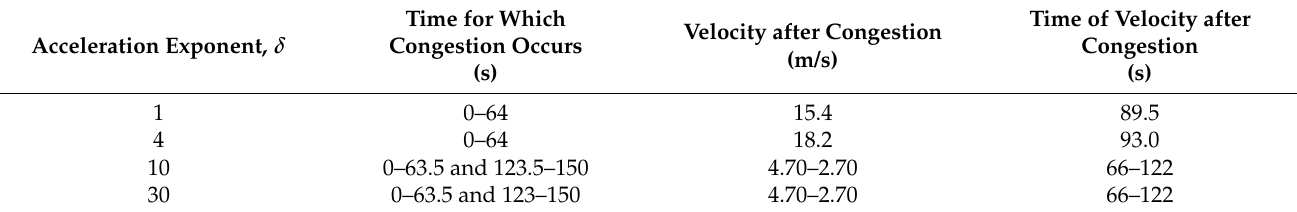
Table 5. Velocity and time for the ID model during and after